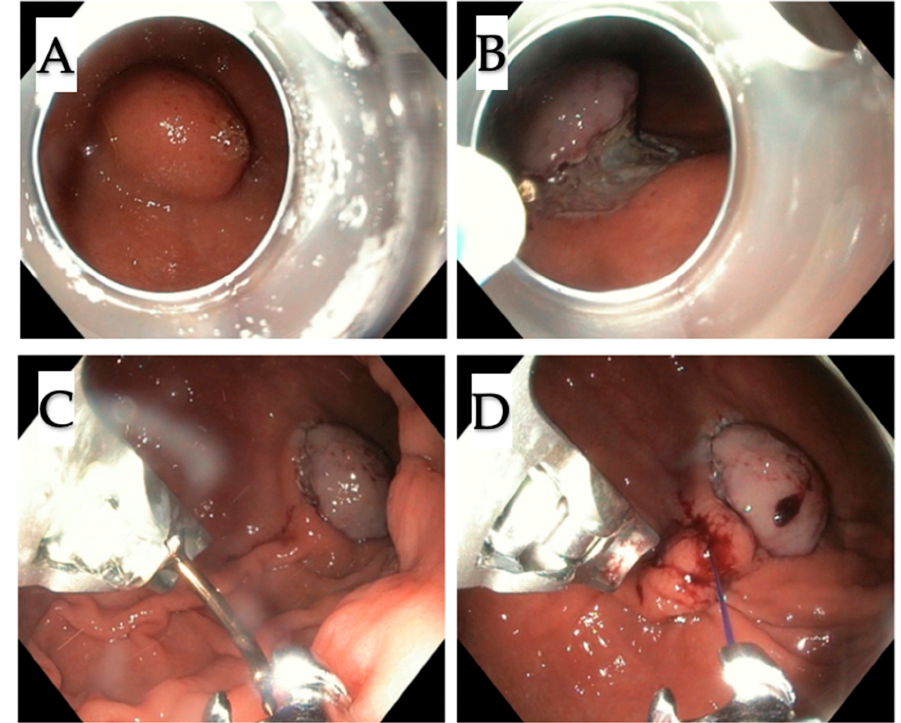
Figure 3. First step of the procedure (case 4). ( A , B ) Marking the tumor and circular incision around the tumor with submucosal dissection; ( C , D ) then adjacent folds of the stomach wall with Apollo OverStitch were bringing together. Tumor was partly lifted up, which provided protection against the perforation during further